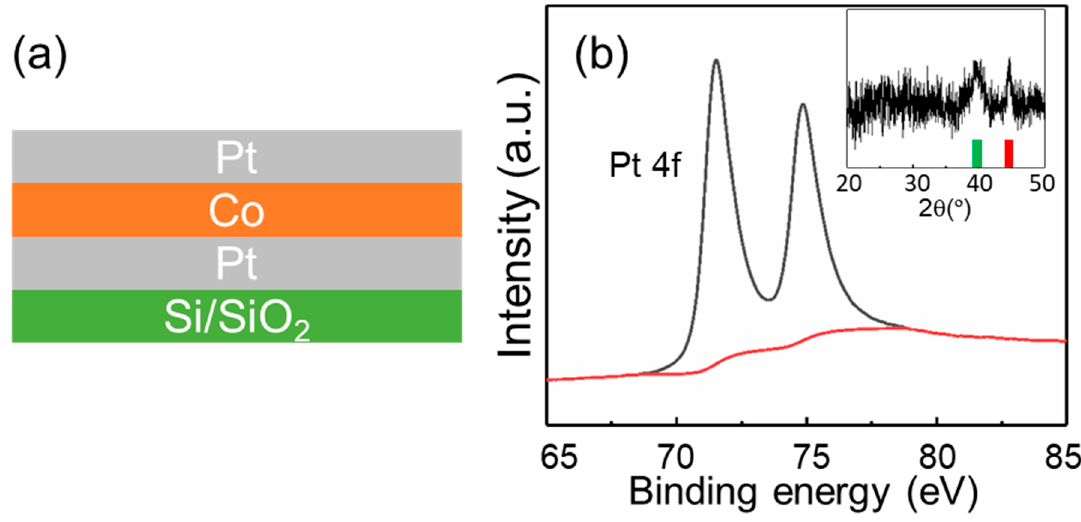
Figure 1. ( a ) Schematic of Pt/Co/Pt heterostructure on Si/SiO 2 substrate. ( b ) XPS survey spectra of the Pt in Pt/Co/Pt heterostructure. The inset is the XRD spectra of the